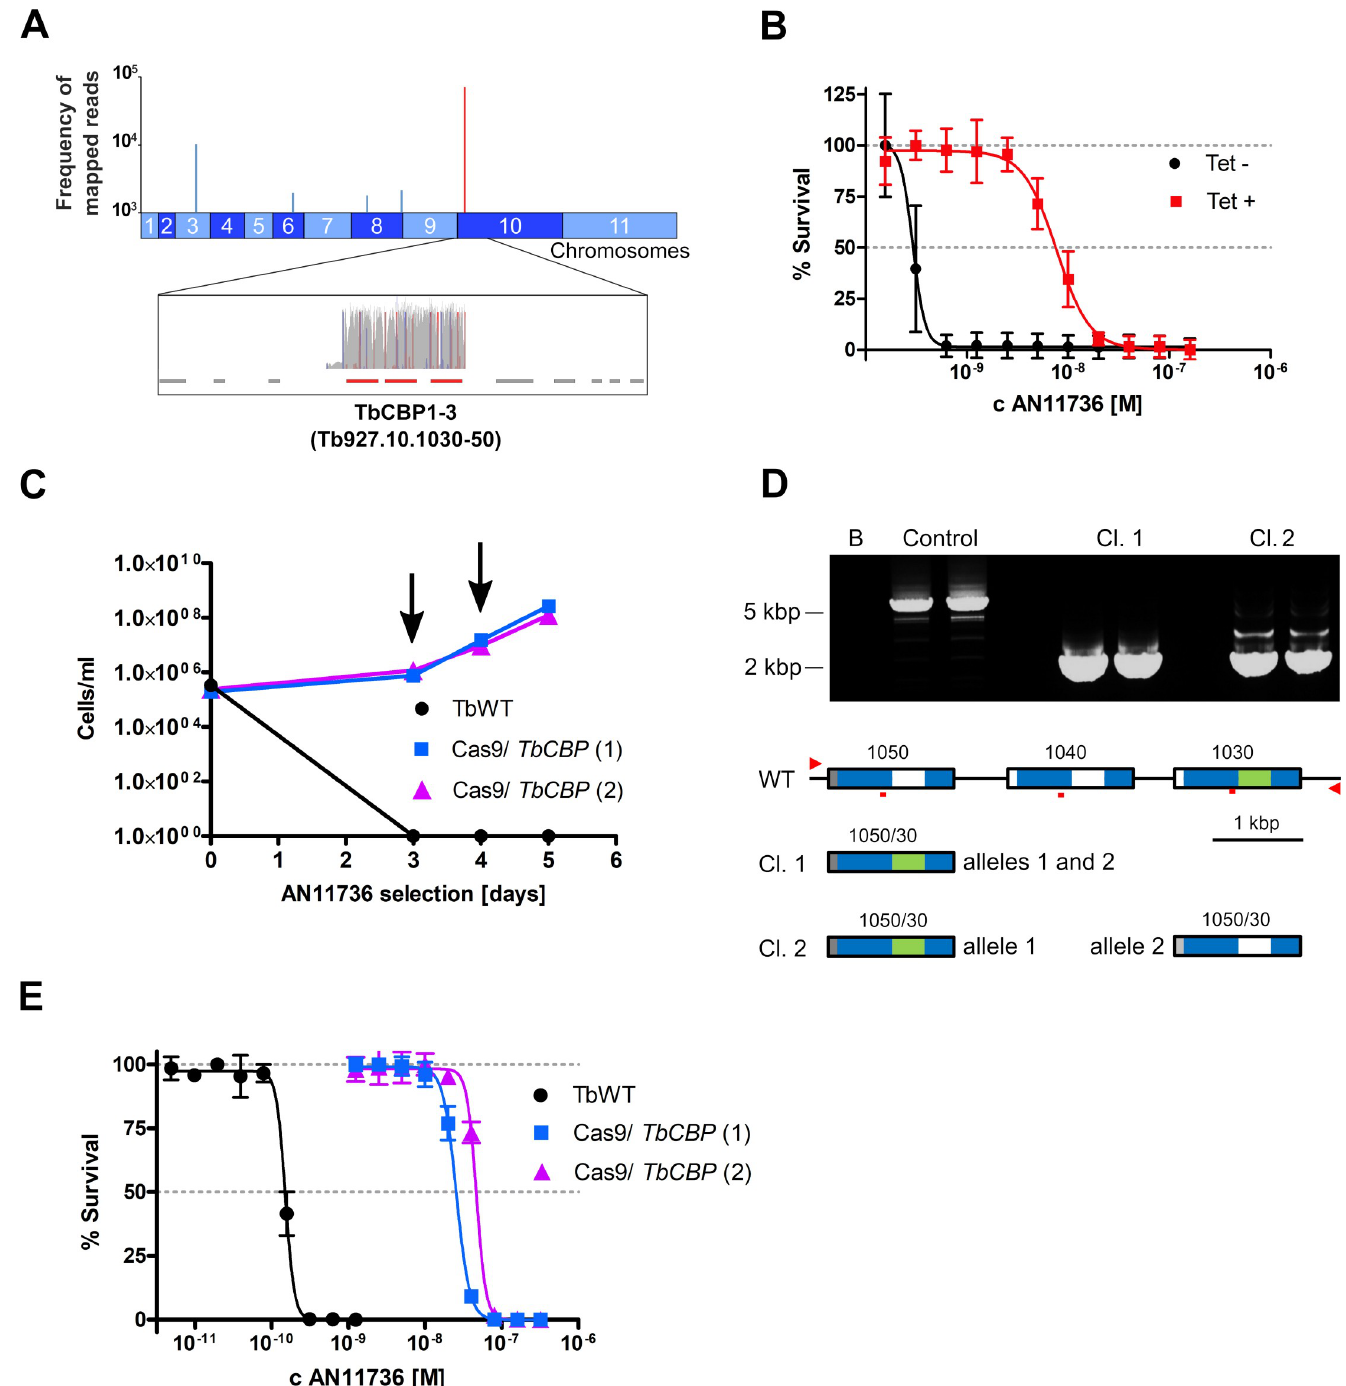
Fig 3. Serine carboxypeptidase disruption confers resistance to AN11736. (A) Genome-wide RIT-seq screen in T . brucei identified the CBP1 genes on chromosome 10 as ‘hits’ for AN11736 resistance. In the lower panel, blue and red peaks are forward and reverse barcoded reads from individual RNAi target fragments; grey, all other reads. (B) Targeted CBP1 RNAi knockdown of the three serine carboxypeptidases in T . brucei conferred resistance to AN11736 under tetracycline induction (Tet + EC 50 7.7 nM, Tet- EC 50 0.3 nM). (C) Cumulative cell growth in the presence of 10 nM AN11736 (arrows indicate addition of fresh drug) for uninduced T . brucei and two independent induced Cas9/sgRNA CBP1A-C clones, following 24 h of Cas9 induced editing in the latter case. (D) A PCR assay of the Cas9/sgRNA CBP1A-C clones revealed TbCBP1 editing in two independent drug-resistant clones (upper panel, duplicate samples are shown); the locus from the uninduced line yielded a product of approximately 5.7 kbp, while both clones yielded a product of approximately 2 kbp. B (blank), no genomic DNA; control, uninduced line genomic DNA; predicted wild type CBP1 fragment size, 5,696 bp. The maps in the lower panel indicate the edited loci, as determined by sequencing. The small red bars indicate the gRNA